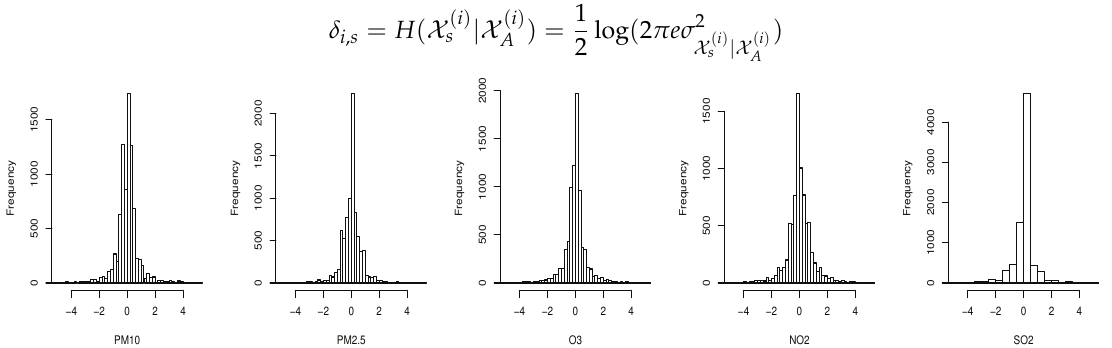
Figure 4. Histogram of the normalized one-hour difference of the hourly measurements at Tung Chung station over the year 2017.